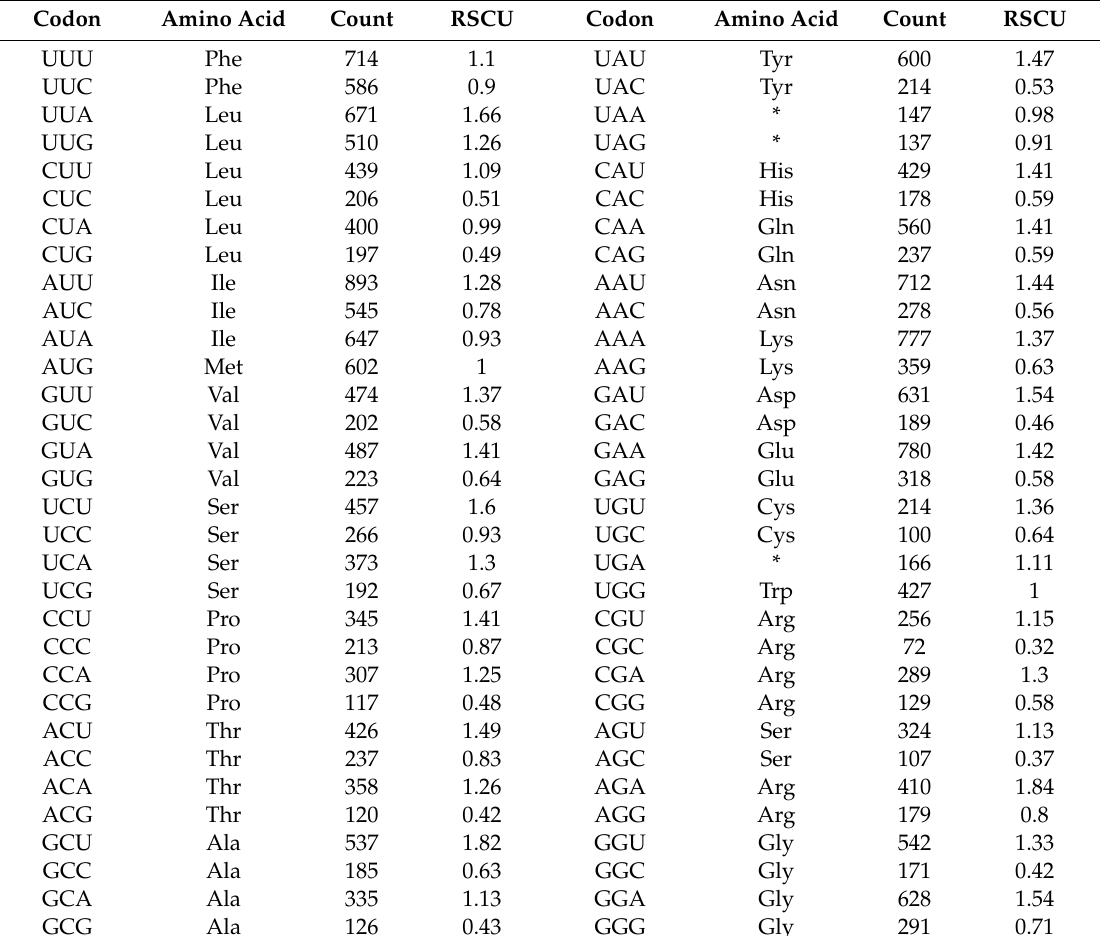
Table 4. Relative synonymous codon usage (RSCU) in the chloroplast genome of Michelia shiluensis